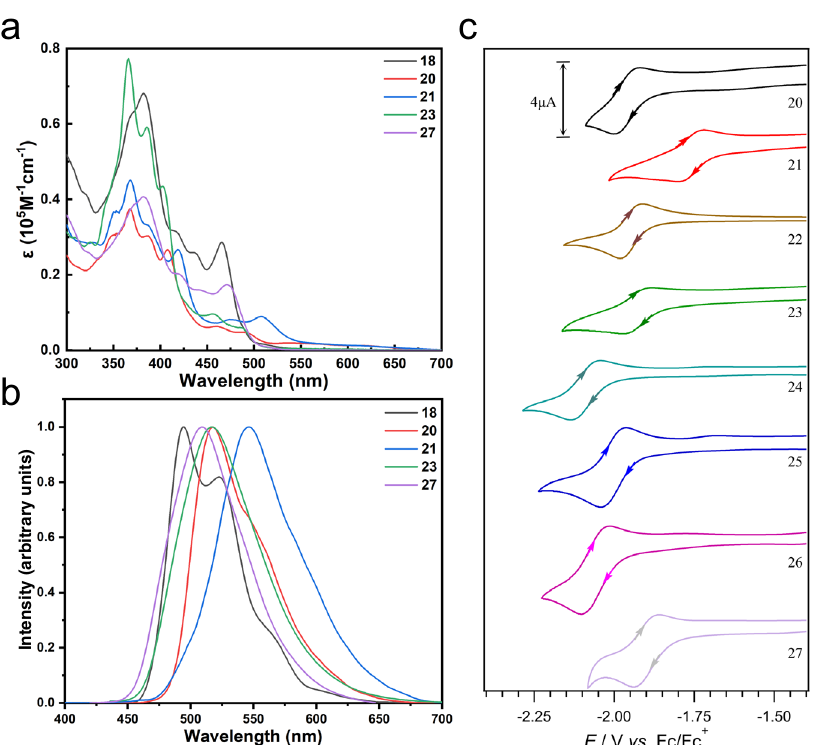
Fig. 6 | Optical and electronic properties. a UV-Vis absorption spectra in dichloromethane at room temperature at a concentration of 10 − 5 molL − 1 (com- pounds 18 , 20 , 21 , 23 ,and 27 arerepresentedbyblack,red,blue,green,andpurple coloredlines,respectively). b Fluorescenceemissionspectraindichloromethaneat room temperature. The same color scheme is used as in the case of absorption